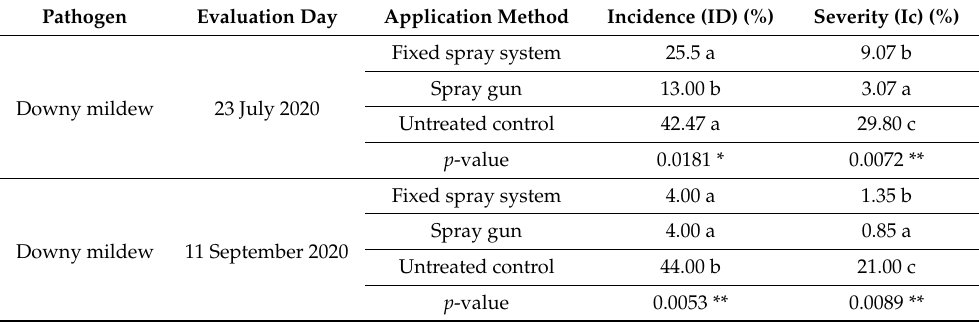
Table 6. Infection of grapevines with powdery mildew and grey mildew in Soave vineyard: com- parison between the two spray-application techniques and the untreated control. Different letters indicate significant statistical differences. * = p -value < 0.05.